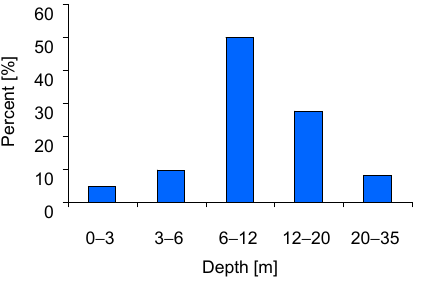
Figure 3. Water depth along selected fragments of transects (marked in orange in Figure 2) from the subset of acoustic data adopted for the analysis (Dejguny Lake, 7/8 October 2021).